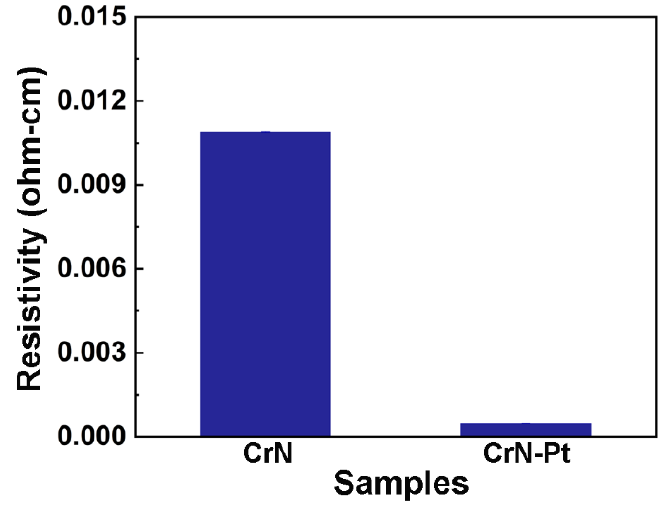
Figure 5. Resistivity of the as-deposited CrN and CrN – Pt coatings.